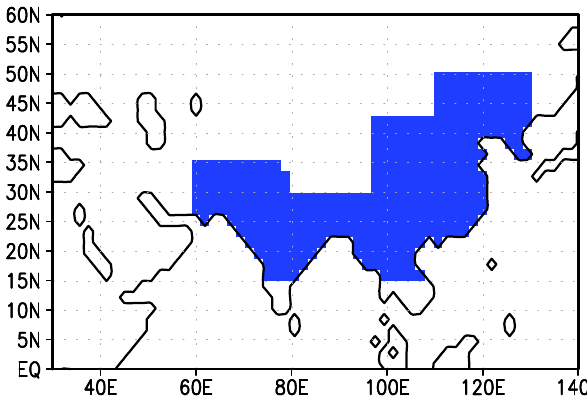
Fig. 1. Extended Asian monsoon region (shaded). In this region, land cover is changed either to forest or to grass in the afforestation and deforestation experiment,